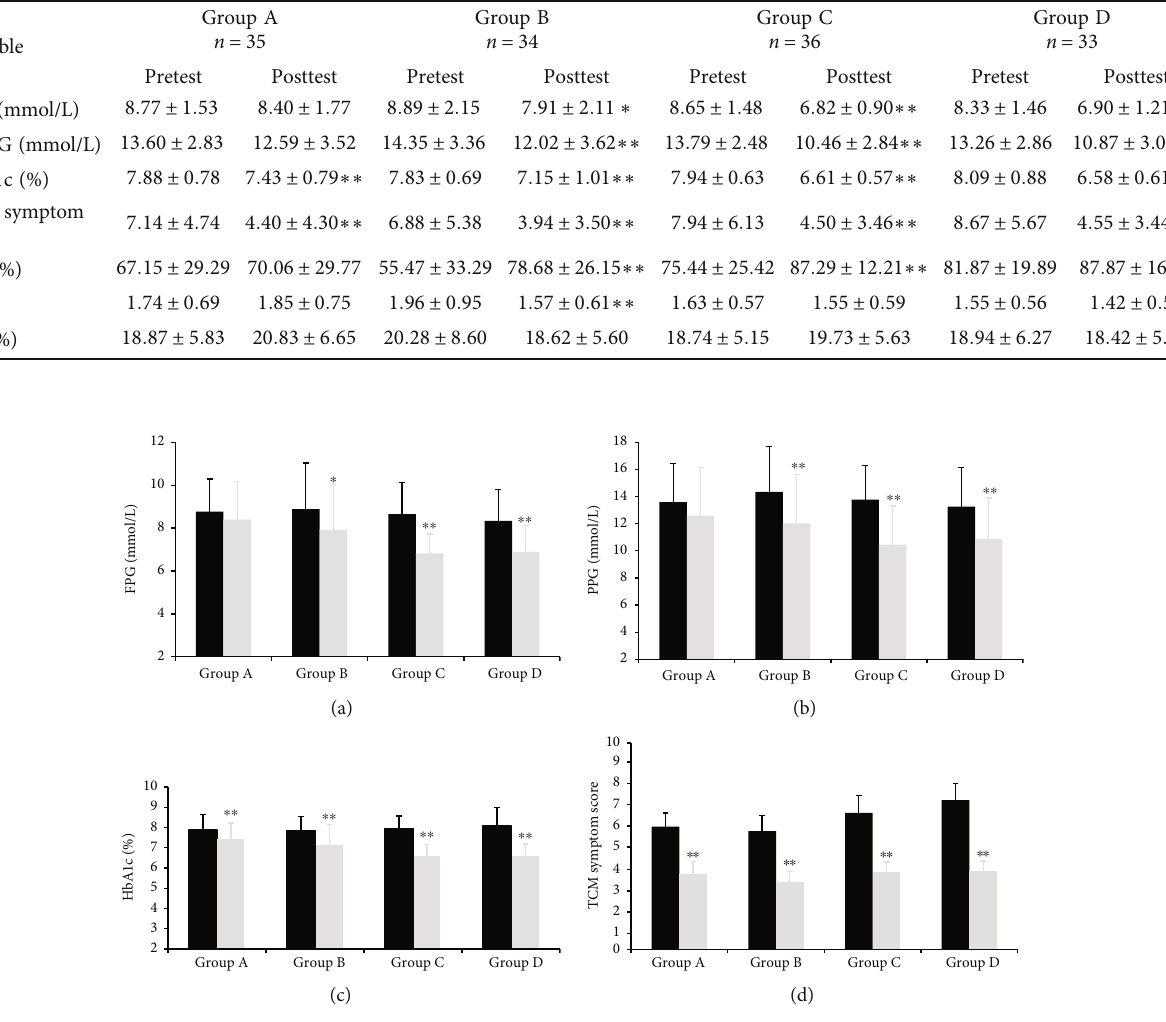
Figure 2: Comparison of Glycemic level and traditional Chinese medicine symptom score at pre-and post-test. (A): Comparison of fasting plasma glucose level at pre-and post-test. (B): Comparison of 2-hour postprandial plasma glucose level at pre-and post-test. (C): Comparison of HbA1c at pre-and post-test. (D): Comparison of traditional Chinese medicine symptom scores at pre-and post-test. Group A: control group; Group B: Jinlida group; Group C: metformin group and Group D: combination treatment group. FPG: fasting plasma glucose; PPG: 2 hour postprandial plasma glucose; TCM: traditional Chinese medicine. ∗ post-test vs. pre-test, P < 0.05, ∗∗ post- test vs. pre-test, P <